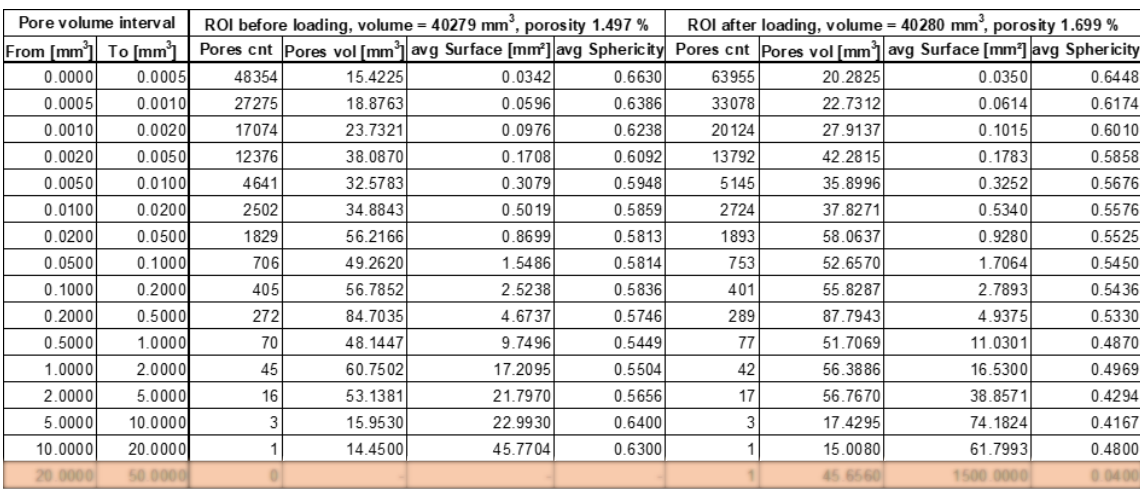
Figure 4. Table summarizing selected porosimetric parameters.